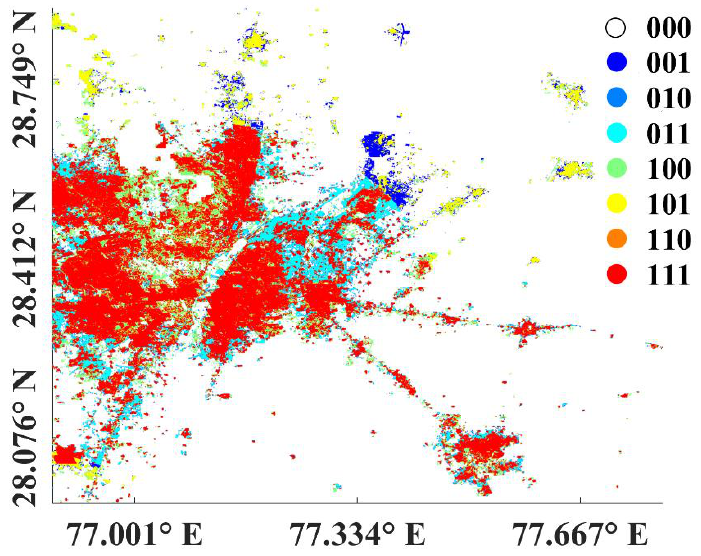
Figure 3. Example of the combination of the land-cover types in three different dates.